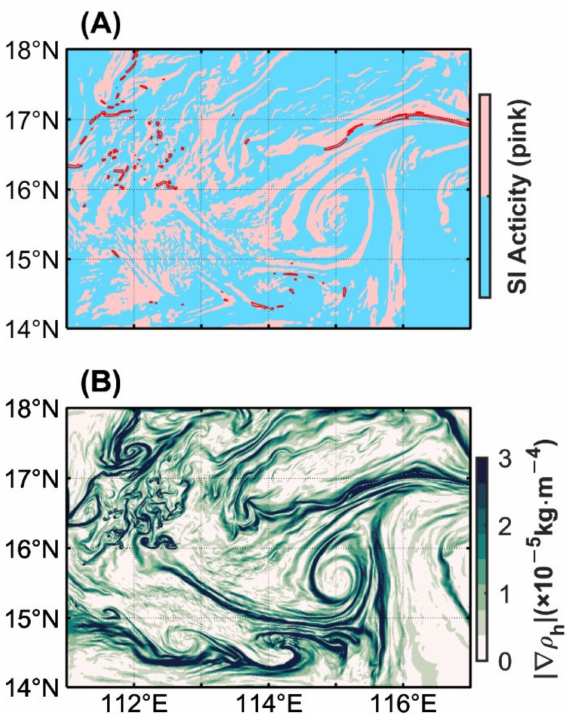
Figure 5. Snapshots of ( A ) the distribution of SI activity overlaid by the 0.1 ((kg m − 3 ) km − 1 ) 2 day − 1 frontogenetic tendency contour and ( B ) the horizontal gradient of density ( 4 December